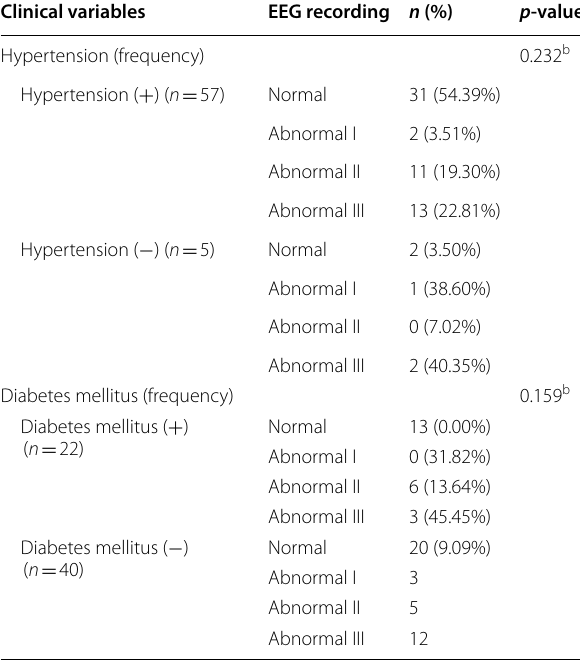
Table 5 Factors analysis related to functional